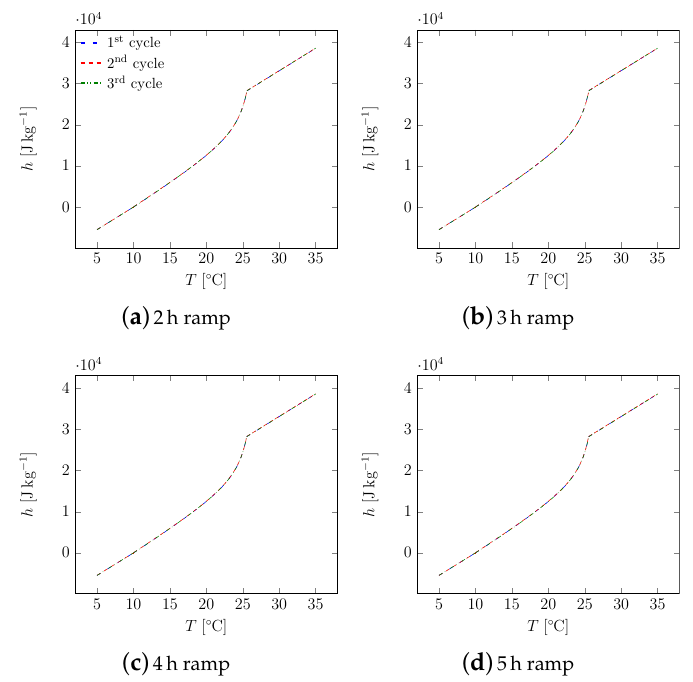
Figure A12. 12.4% w -PCM mortar: comparisons of the identified enthalpy functions with respect to the heating/cooling ramp ( n.b. unique formulation pertaining for both fusion and crystallization).